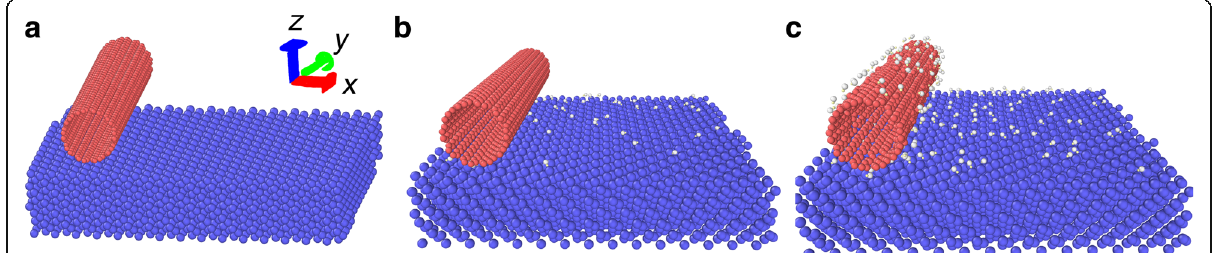
Fig. 1 Simulation models. a Ideal. b Si substrate covered with hydroxyl groups. c Carbon nanotube and Si substrate are both covered with hydroxyl